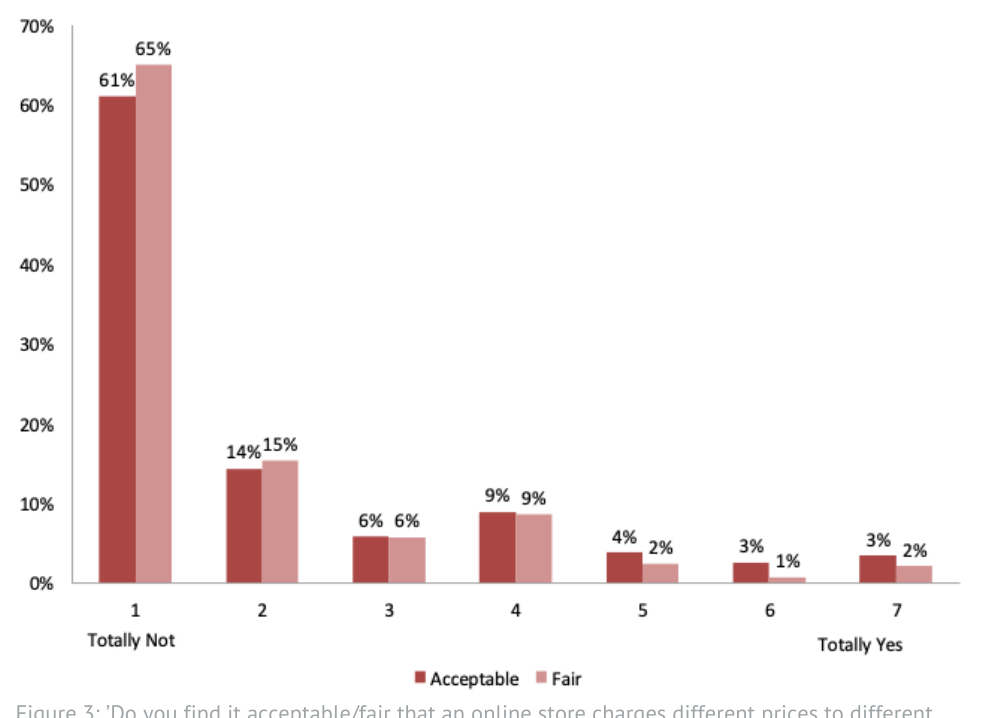
Figure 3: ’Do you find it acceptable/fair that an online store charges different prices to different people for the same product?’